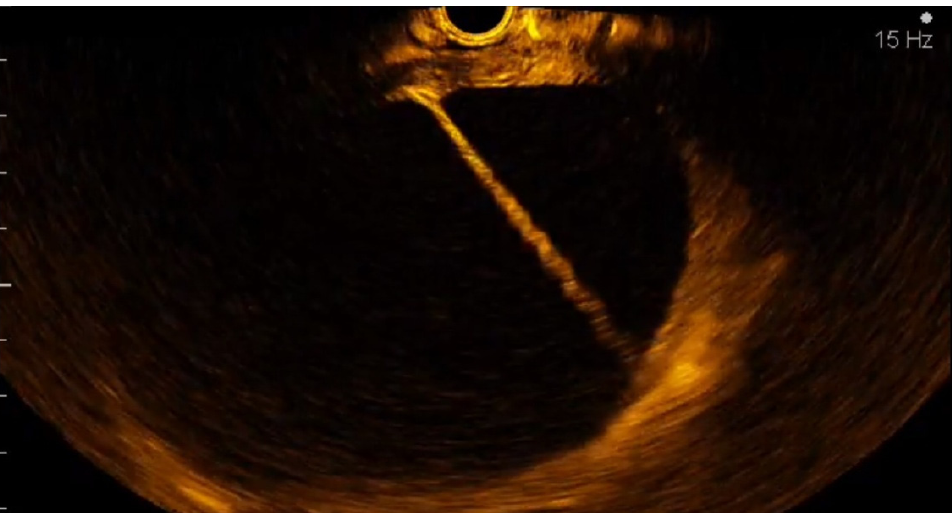
Figure 8. Contrast enhancement of a cystic septae.